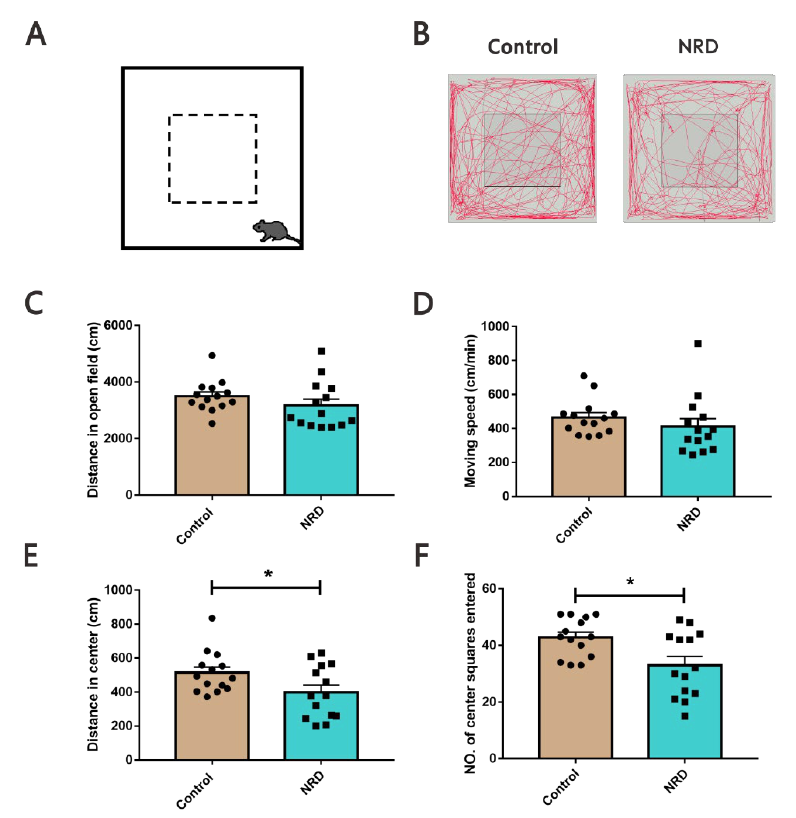
Figure 2. Normal locomotor activity and anxiety-like behavior in NRD mice. ( A ) Diagram of the open field apparatus (the peripheral (between solid and dotted lines) and central (inside the dotted line) regions). ( B ) Representation of the locomotion tracing for control and NRD mouse in the open field test. ( C – F ) Performances of the control and NRD mice in terms of distance in open field ( C ), moving speed in open field ( D ), in center zone ( E ), and number of center squares entered ( F ). * p < 0.05 as determined by unpaired Student’s t -test. Data are expressed as the means ± SEMs. n (control) = 14, n (NRD) = 14.